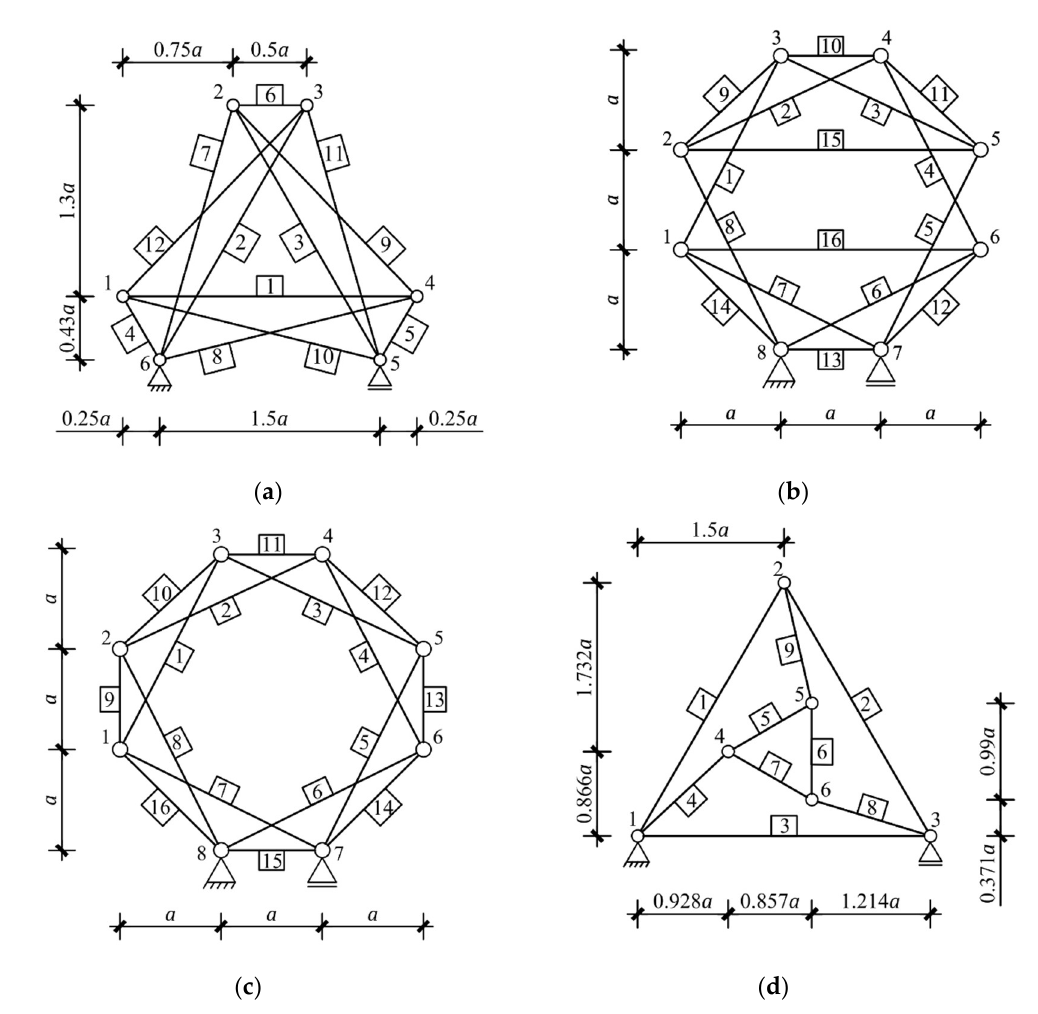
Figure 11. Four trusses (a - d) with no tensegrity features.